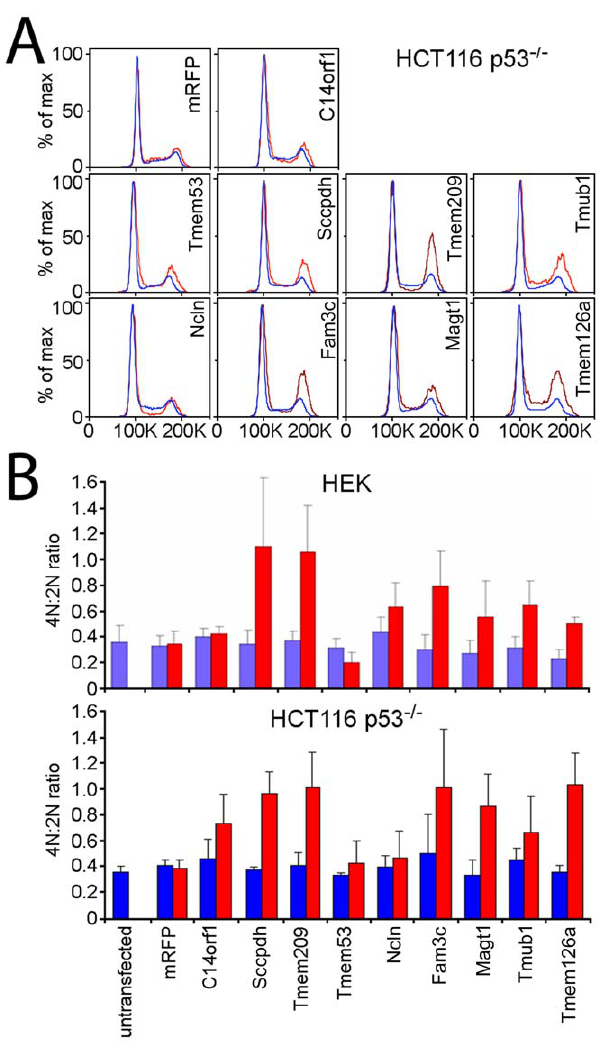
Figure 3. Cell cycle effects of NET4/Tmem53 and NET59/Ncln depend on p53. (A) Flow cytometry profiles of cells expressing NET- mRFP fusions in HCT116 p53 2 / 2 cells. Most NETs that had produced increases in the 4N population in Figure 1 yielded similar increases in the 4N population in HCT116 p53 2 / 2 cells; however, NET4/Tmem53 and NET59/Ncln lost their effects. (B) The percentage of cells in the 4N and 2N populations were calculated and 4N:2N ratios were plotted from at least three separate experiments with standard errors shown. The results for the HEK293T cells are shown above those for the HCT116 p53 2 / 2 cells. doi:10.1371/journal.pone.0018762.g003 line that has stable p53- and pRb-dependent checkpoints but is defective for p16INK [23,24].